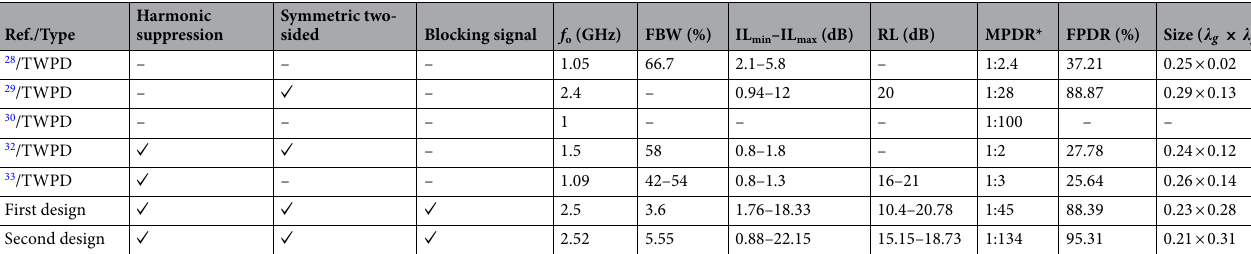
Table 3. Properties comparison of two WPDs with other works (MPDR: Maximum power-dividing